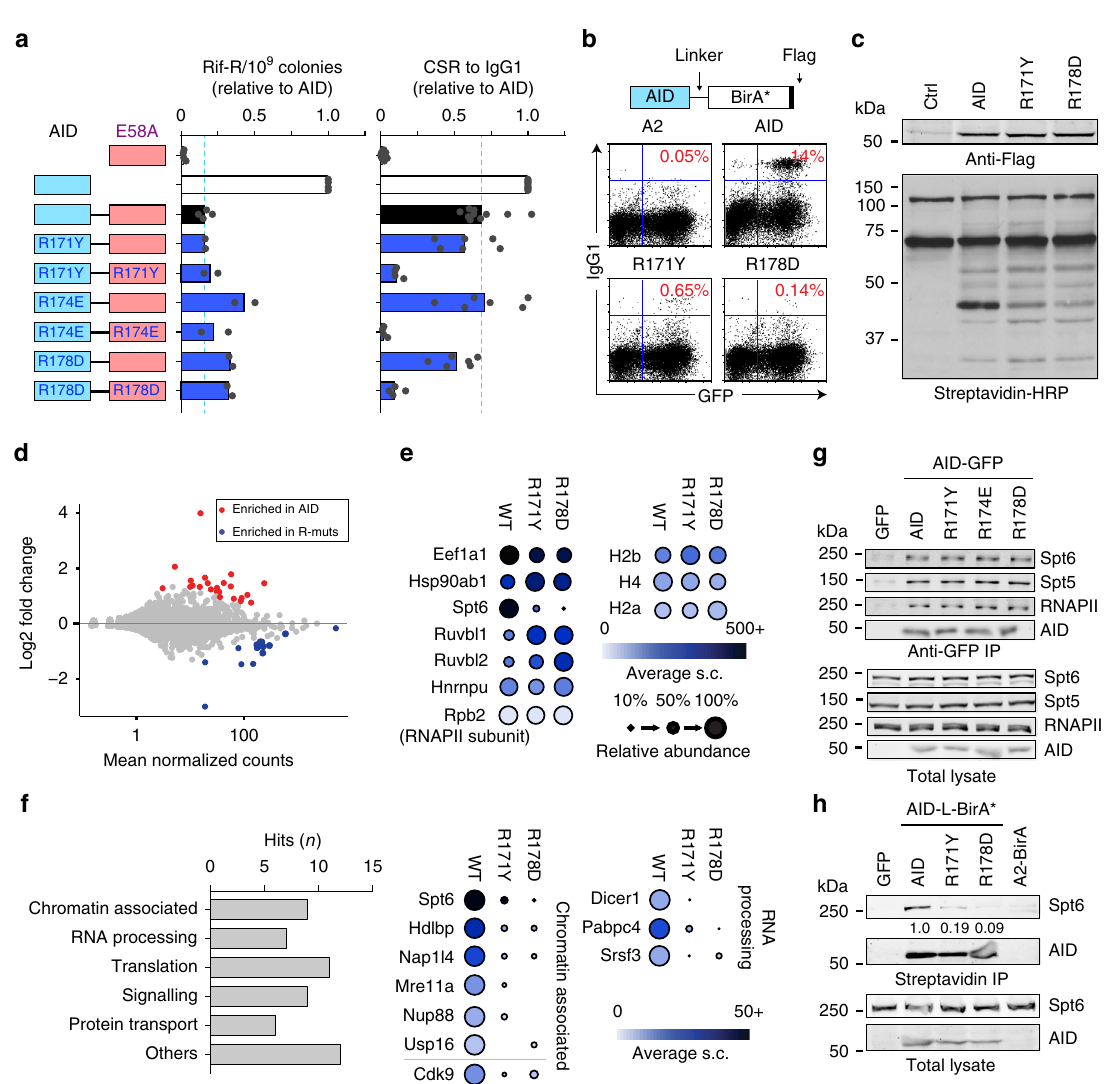
Fig. 6 Protein – protein interactions of AID and R-mutants. a (Left) schemes of AID, AID E58A and fusions thereof indicating additional mutations. (Middle) Relative ability to produce rifampicin resistant (Rif-R) E. coli colonies is shown by means (bars) of median values (dots) from 2 to 4 independent experiments (5 clones/experiment), normalized to the median of AID from each experiment. (Right) Relative CSR capacity of the same proteins expressed in Aicda − / − mouse B cells. Means (bars) from 4 to 10 independent mice (dots) from 2 to 5 independent experiments are shown, normalized to AID. b Schematic of the AID fusions to BirA* and representative fl ow cytometric plots for CSR, the proportion of IgG1 + cells in the GFP + population, in reconstituted Aicda − / − mouse B cells. APOBEC2 (A2) was used as control. c Representative WB of the AID-BirA* fusions (anti- fl ag) and biotinylated targets (streptavidin) from reconstituted Aicda − / − mouse B cells after incubation with biotin. Untransduced cells were used as control (Ctrl). d MA plot showing the fold change in spectral counts (s.c.) as a function of average s.c. of all hits for wt AID versus R-mutants. Red and blue dots represent signi fi cant differences identi fi ed according to negative binomial distribution by the DESeq2 software. e (Left) Circle plots of BioID signal for selected known AID interacting partners. Circle size indicates relative abundance normalized to the variant with the most s.c. Circle colour represent actual s.c. Scales are shown. f (Left) Broad functional categories of BioID associations found reduced in the R-mutants compared to wt AID. (Right) Circle plots for hits in the indicated categories. g Anti-GFP pull down from whole-cell lysates of AID-de fi cient CH12 B cells reconstituted with AID variant-GFP fusions. Spt6, Spt5, RNAPII and AID were detected by WB from immunoprecipitates or lysates. Representative of two independent experiments. h Streptavidin pull down of biotinylated proteins from whole-cell lysates of AID-de fi cient CH12 B cells reconstituted with AID variant-BirA* fusions after 24 h pulse of biotin. Spt6 and AID were detected by WB from either pull downs or lysates. Ratios of Spt6 to AID signal normalized to AID-BirA* are indicated. Representative of two independent experiments. For gel source data, see supplementary Fig.